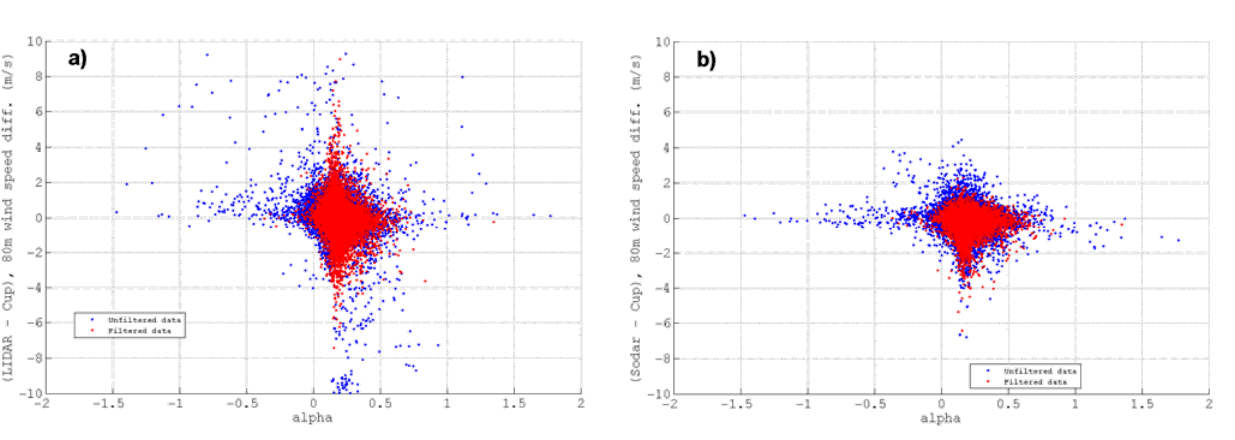
Figure 14. ( a ) LIDAR-Cup, and ( b ) SODAR-Cup, wind speed differences, as a function of wind shear exponent, α (February–May; 10 min